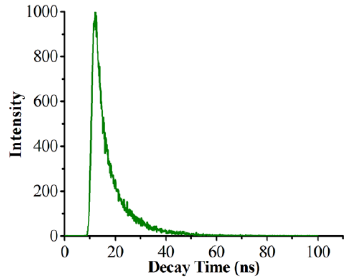
Figure 5. Fluorescence decay curves of the CDs / PNIPAM.